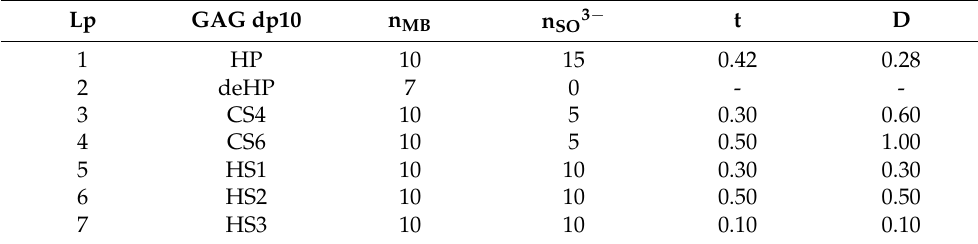
Table 2. Dependence of the number of dye molecules interacting simultaneously with GAGs during MD simulation on the number of sulfate groups in the GAGs under